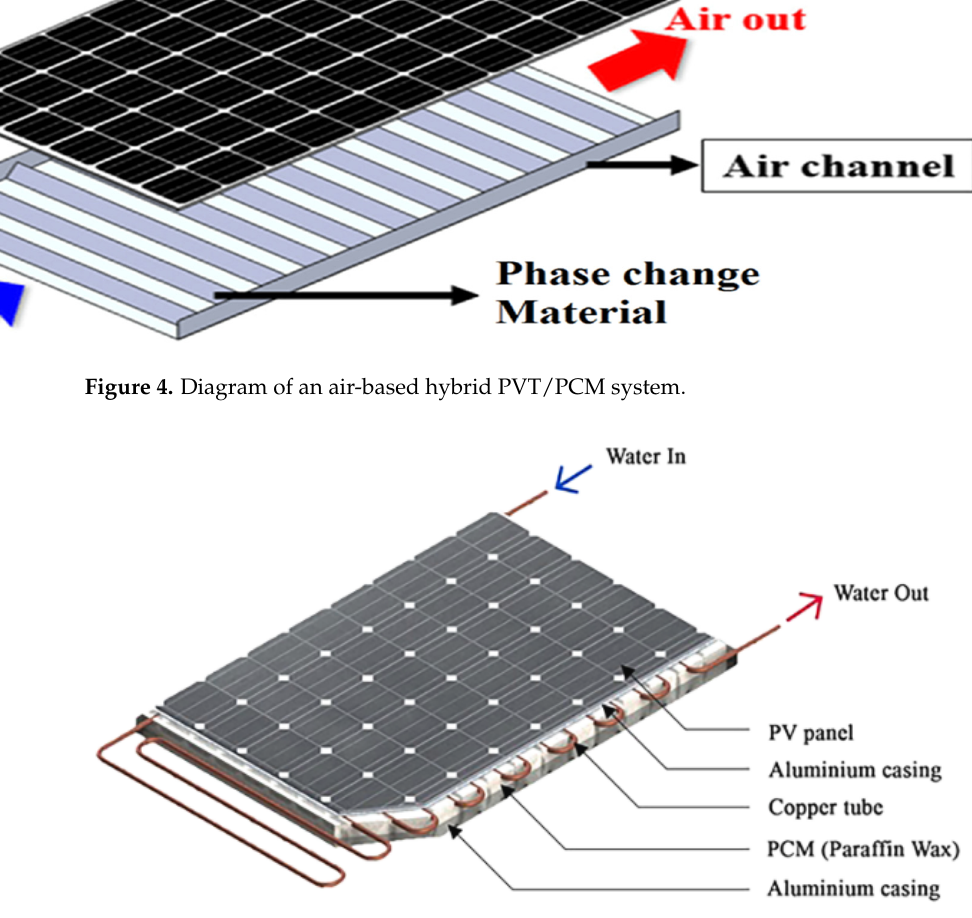
Figure 5. Diagram of a water-based hybrid PVT/PCM system.